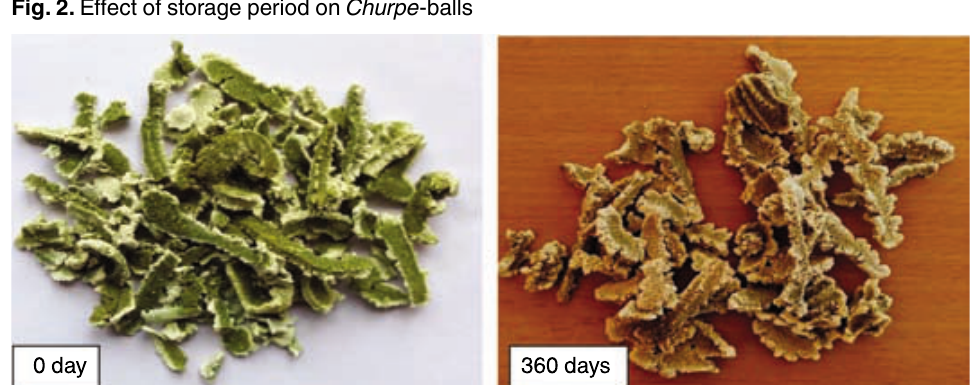
by other workers for the changes in texture due to the incorporation of spinach powder (Lucera et al ., 2018). Loose texture (low firmness) could be due to higher concentration of spinach powder which has fibrous attribute. With the advancement of storage period (360 days), the mean texture scores of balls increased from 5.4 to 6.2 and of strips increased from 7.2 to